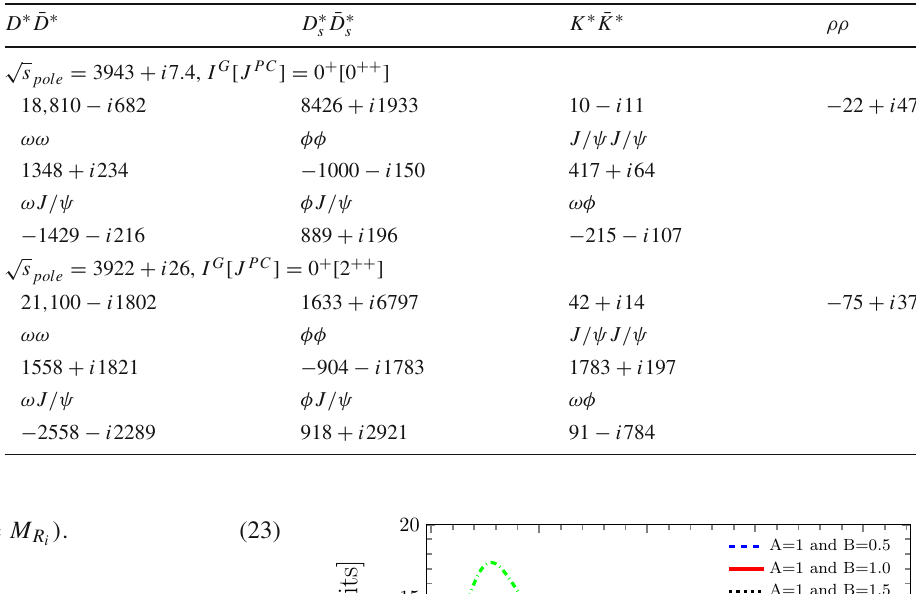
A=1 and B=1.5 A=1 and B=2.0